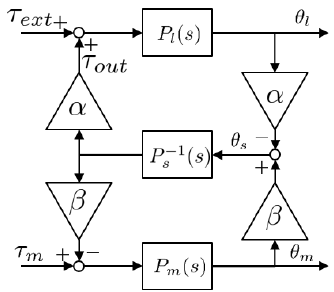
Figure 18. Block diagram platform of generalized dynamic model of